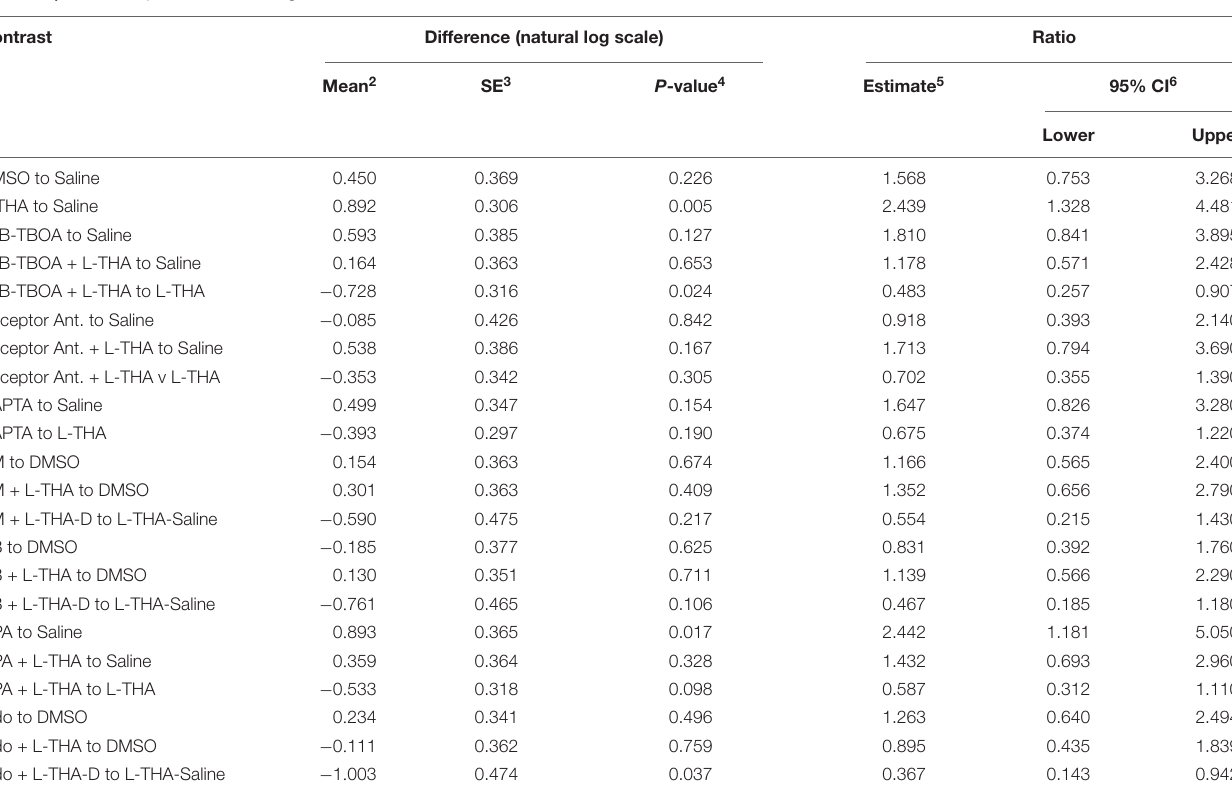
TABLE 3 | Combined pulses – Max change 1